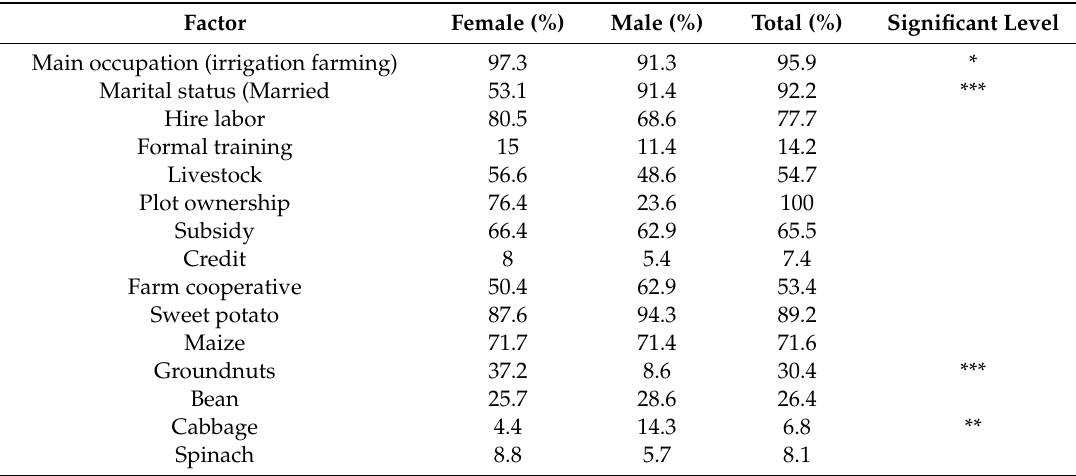
Table 2. Socio-demographic